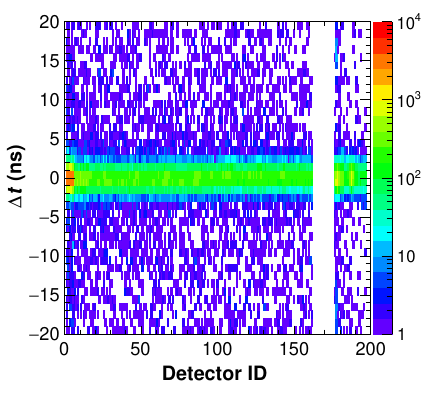
Figure 1. Time di ff erence between the first detector of DANCE and any other of the DANCE and NEUANCE detectors. The DANCE detectors have IDs from 0 to 161 and the NEUANCE detectors from 176 to 196. A window of 5 ns can be used to build coincidences between all detectors.